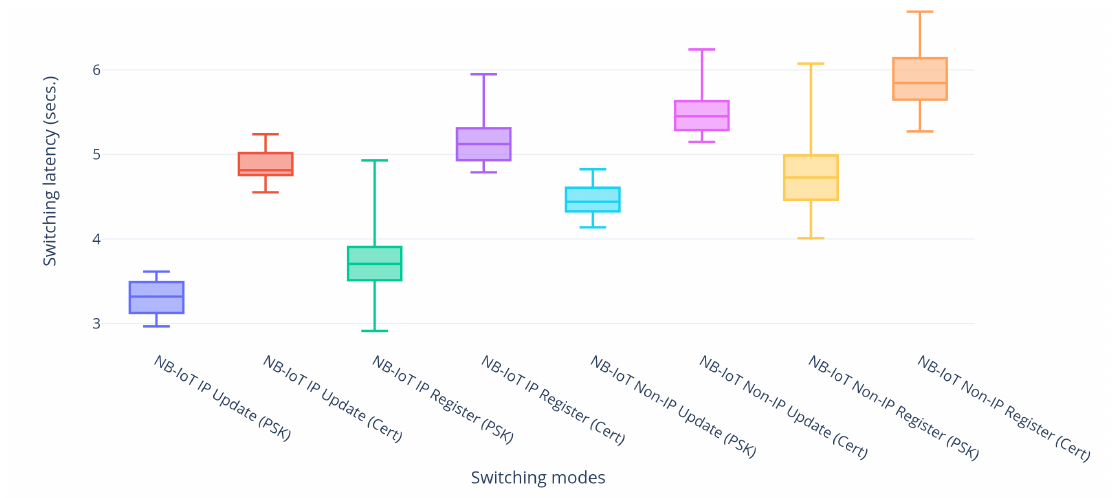
Figure 7. Handover latencies of NB-IoT with DTLS using Pre-Shared Key (PSK) and